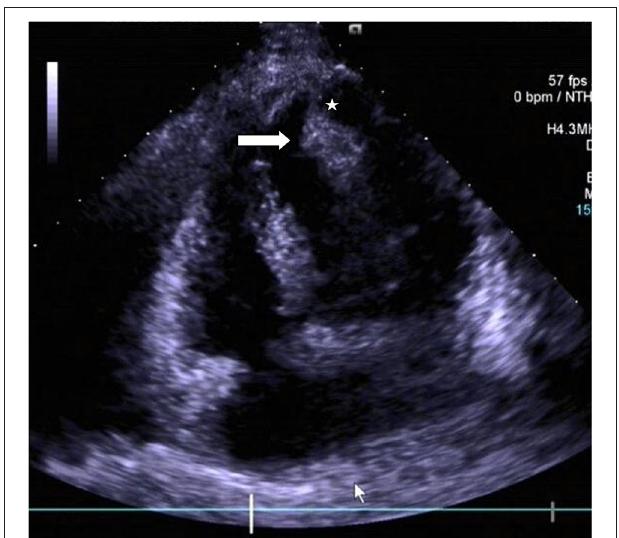
FIGURE 1 | Transthoracic echocardiogram revealing the presence of a pedunculated lobular mass [peduncle (asterisk); mass (arrow head)] within the left ventricle.